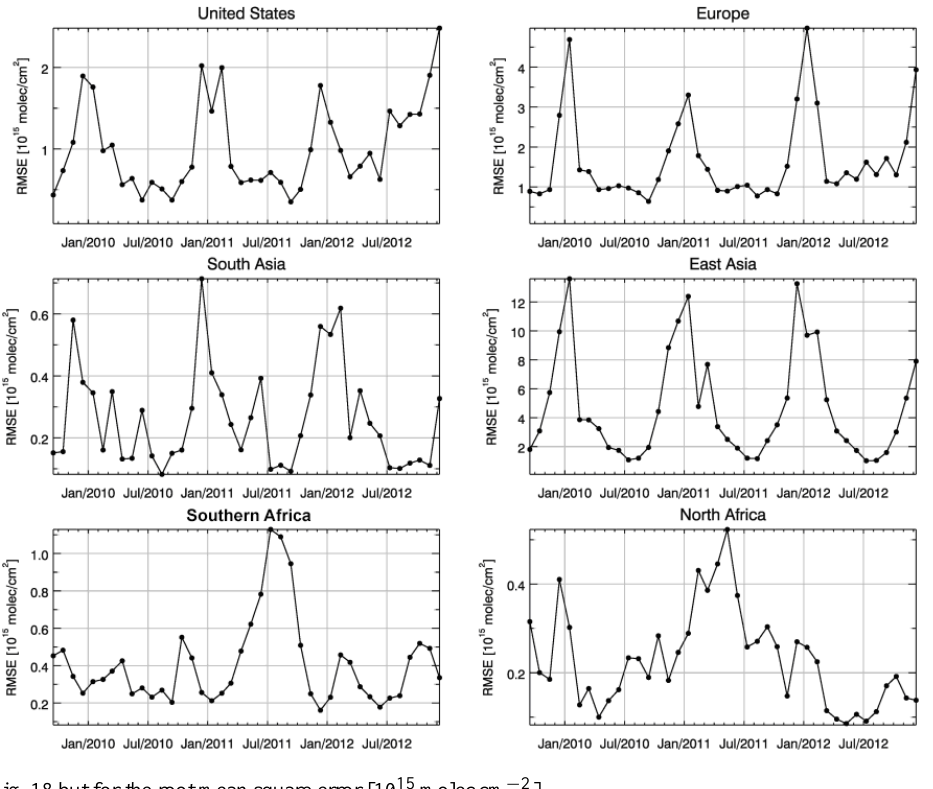
Figure 19. As in Fig. 18 but for the root mean square error [10 15 moleccm − 2 ].